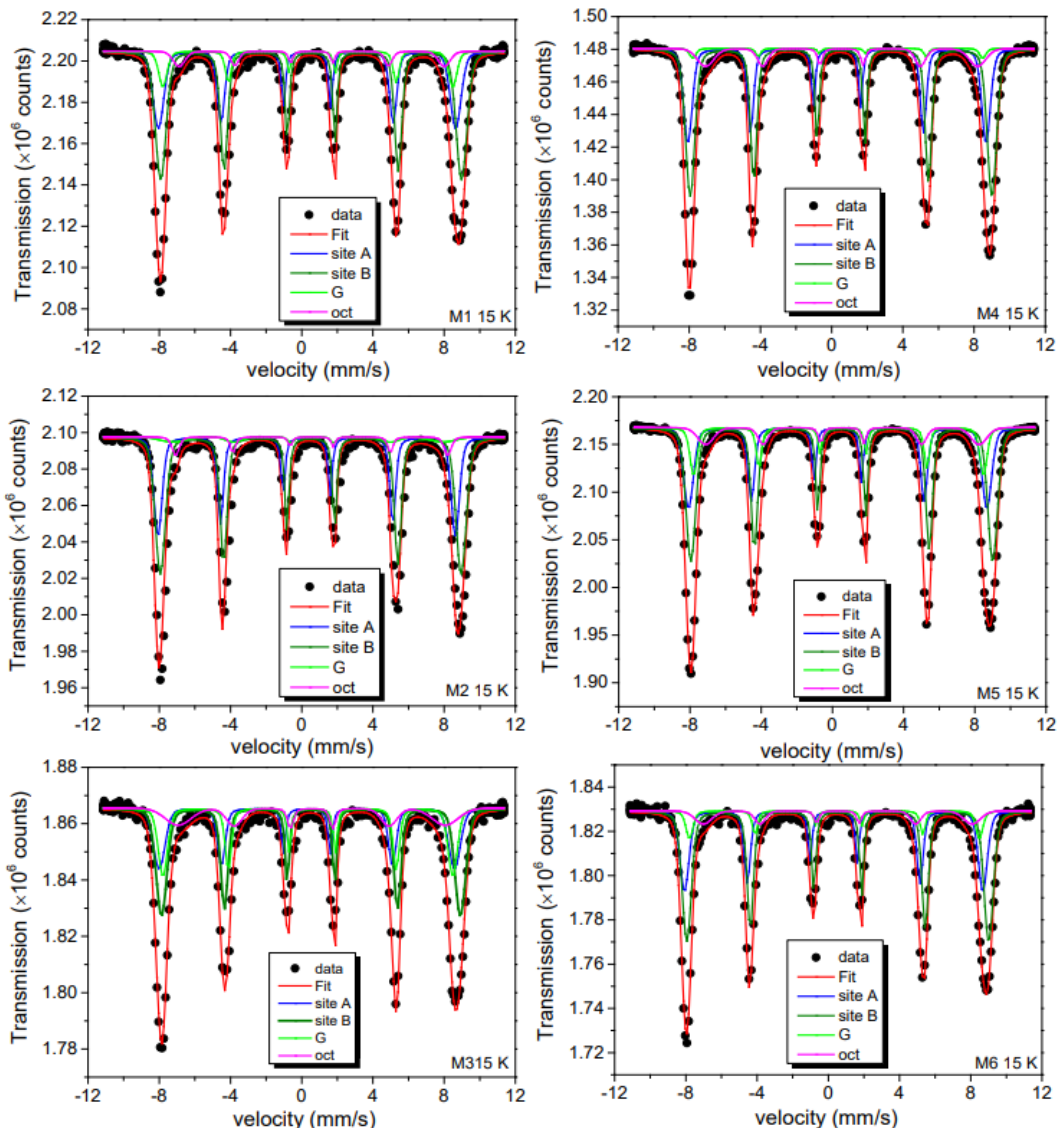
Figure 9. The 15 K 57 Fe Mössbauer results for the M series. The subspectra discussed in the text